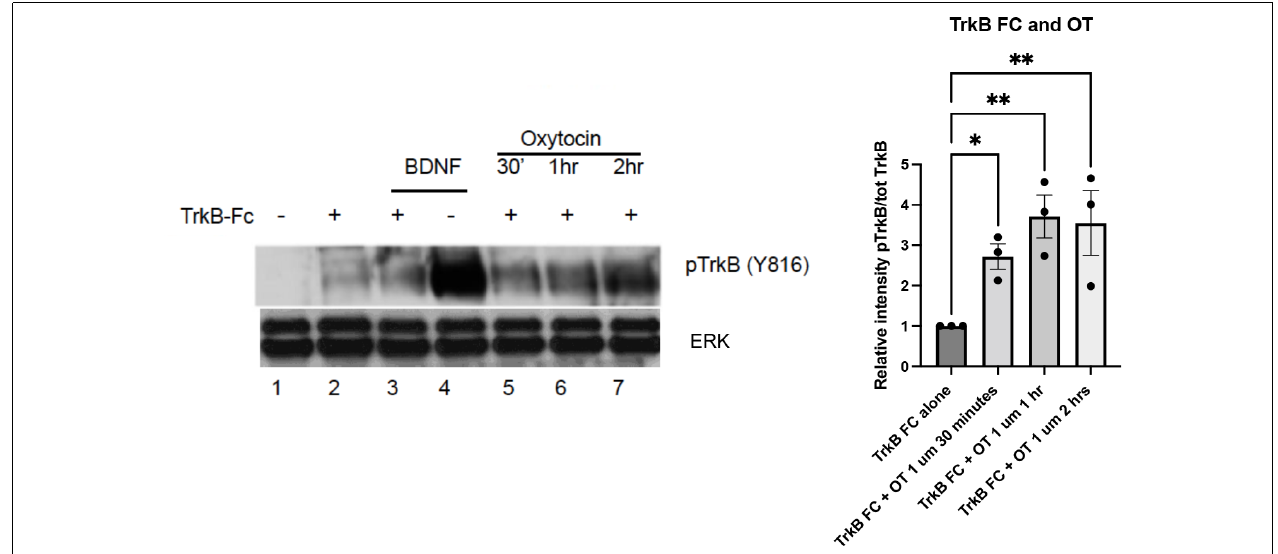
FIGURE 3 | TrkB transactivation by oxytocin is independent of the presence of BDNF. Cortical neurons were treated with 0.1 µ M oxytocin (OT) for 0.5, 1, and 2 h in the presence of TrkB-FC (100 ng/ml). Three independently treated sets of neurons were assessed for responsiveness. BDNF (50 ng/ml) is used as positive control in this experiment. Lane 1, no treatment; Lane 2, TrkB-Fc; Lane 3, BDNF and TrkB, Fc; Lane 4, BDNF alone; Lanes 5-7, TrkB-Fc at 30’, 1 h, 2 h. Lysates were prepared from primary cultures of cortical neurons and run via Western blotting to probe for pTrkB Y816 (from Chao lab) and total ERK levels (Cell Signaling #9102). The graph (right) illustrates the relative density of pTrkB which was calculated by the ratio of the pTrkB densitometric signal over the total ERK densitometric signal for each sample, and then represented as a value relative to untreated control. The significance of TrkB-Fc + oxytocin treatment from the three time points was calculated with one way ANOVA pairwise